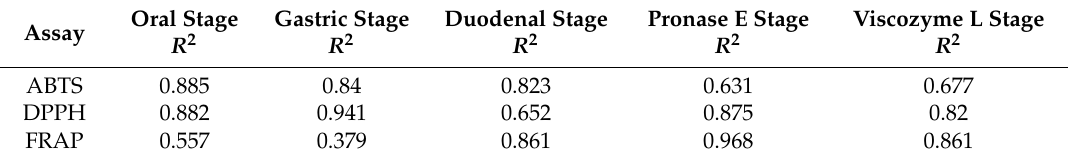
Table 7. Correlation between TPC evaluated by Folin-Ciocalteu and antioxidant activity evaluated by the ABTS, DPPH, and FRAP methods. The correlation coe ffi cients among means were determined using Pearson’s